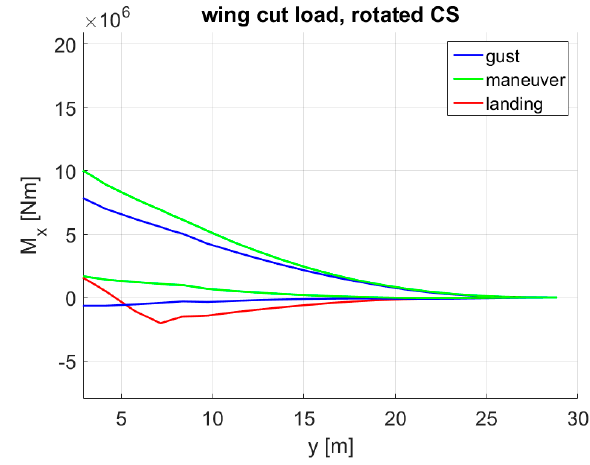
Figure 36. Bending moment envelope with red. load factor.